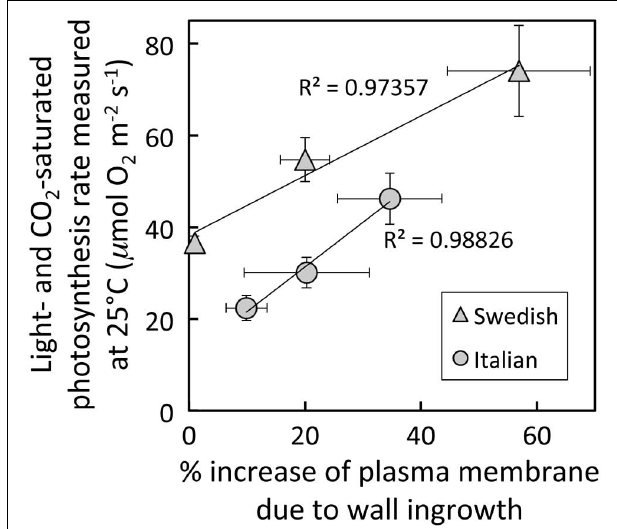
FIGURE 5 | Relationship between the percent increase of parenchyma-cell plasma-membrane length in foliar minor veins and photosynthetic capacity from leaves of Italian (circles) or Swedish (triangles) ecotypes of A. thaliana that developed under 400 μ mol photons m –2 s –1 at a daytime leaf temperature of 36 ◦ C (lowest values), 18 ◦ C (intermediate values), or 14 ◦ C (highest values). The linear relationship among all six values (not shown) was significant at P < 0.05, whereas the linear relationships shown for each ecotype were not. Photosynthetic capacities from leaves that developed at 14 ◦ C from Cohu etal. (2013b).